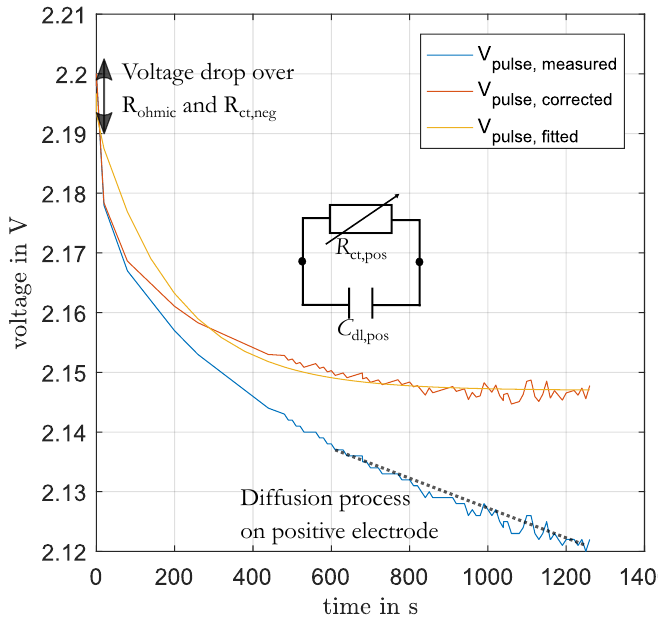
Figure 4. Illustration of the pre-processing and fitting of a discharge pulse for the parameterization of positive